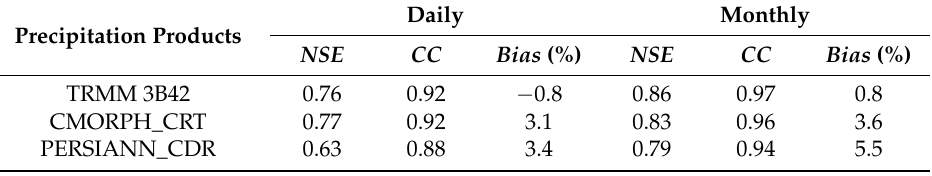
Table 6. Comparison of daily and monthly observed and simulated streamflow under Scenario II.